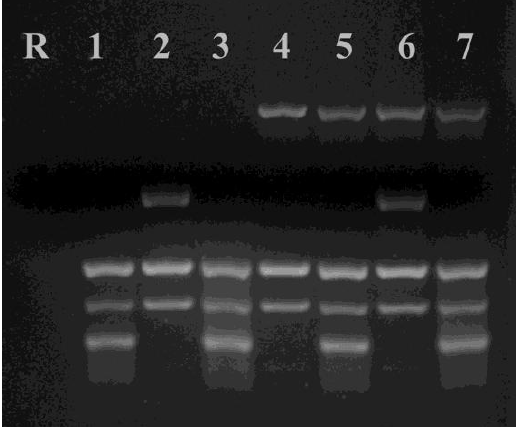
Figure 2. Selection of DNA targets for inclusion in a multiplex PCR for detection of N. caninum genotypes.The results of using different combinations of targets and primers are shown using Nc-Liverpool DNA. Primers that amplify microsatellite (Tand-3) and minisatellite targets (Tand-12, Tand-13, Cont-13 and Cont-16) were used. R, Control (ddH O); 1, from bottom band to top, Tand-3, Tand-12 and Tand-13; 2, Tand-12, Tand-13 2 and Cont-13 (not amplified); 3, Tand-3, Tand-12, Tand-13 and Cont-13 (not amplified); 4, Tand-12, Tand-13 and Cont-16; 5, Tand-3, Tand-12, Tand-13 and Cont-16; 6, Tand-12, Tand-13, Cont-13 and Cont-16; 7, Tand-3, Tand-12, Tand-13, Cont-13 (not amplified) and Cont-16. From the results of these combination experiments we conclude that primers to Tand-3 interfere with amplication of Cont-13. The sizes of the PCR products (bp) for NC-Liverpool [129] are Tand-3, 192; Tand-12, 277; Tand-13, 340; Cont-13, 507; Cont-16, 854. The primers used are described in [129].